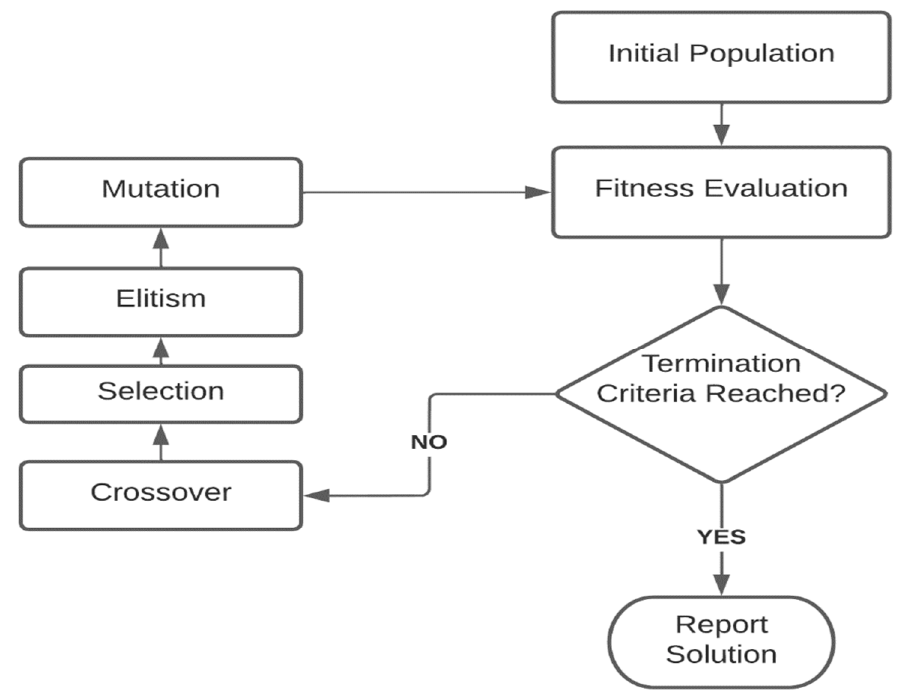
Figure 2. GA Attribute Weight Optimization Framework.